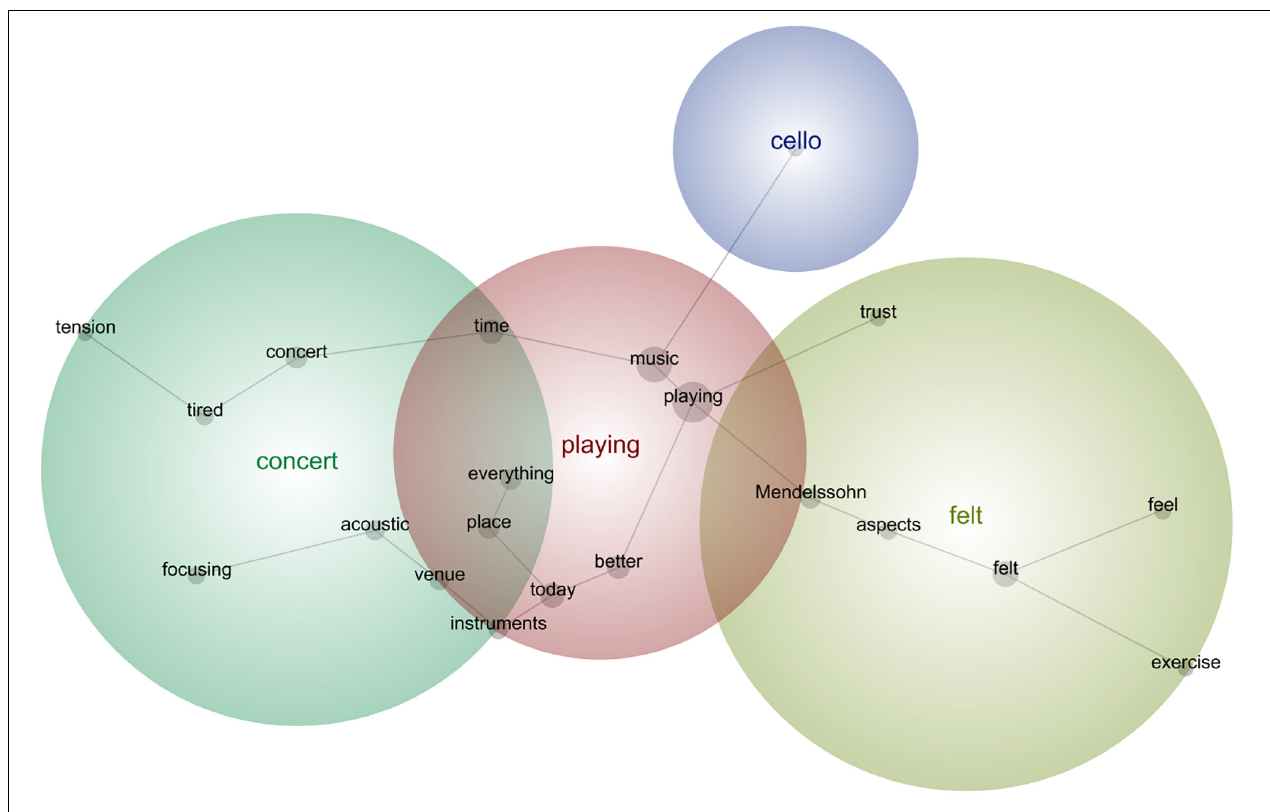
FIGURE 12 | Leximancer concept map for Concert 8.